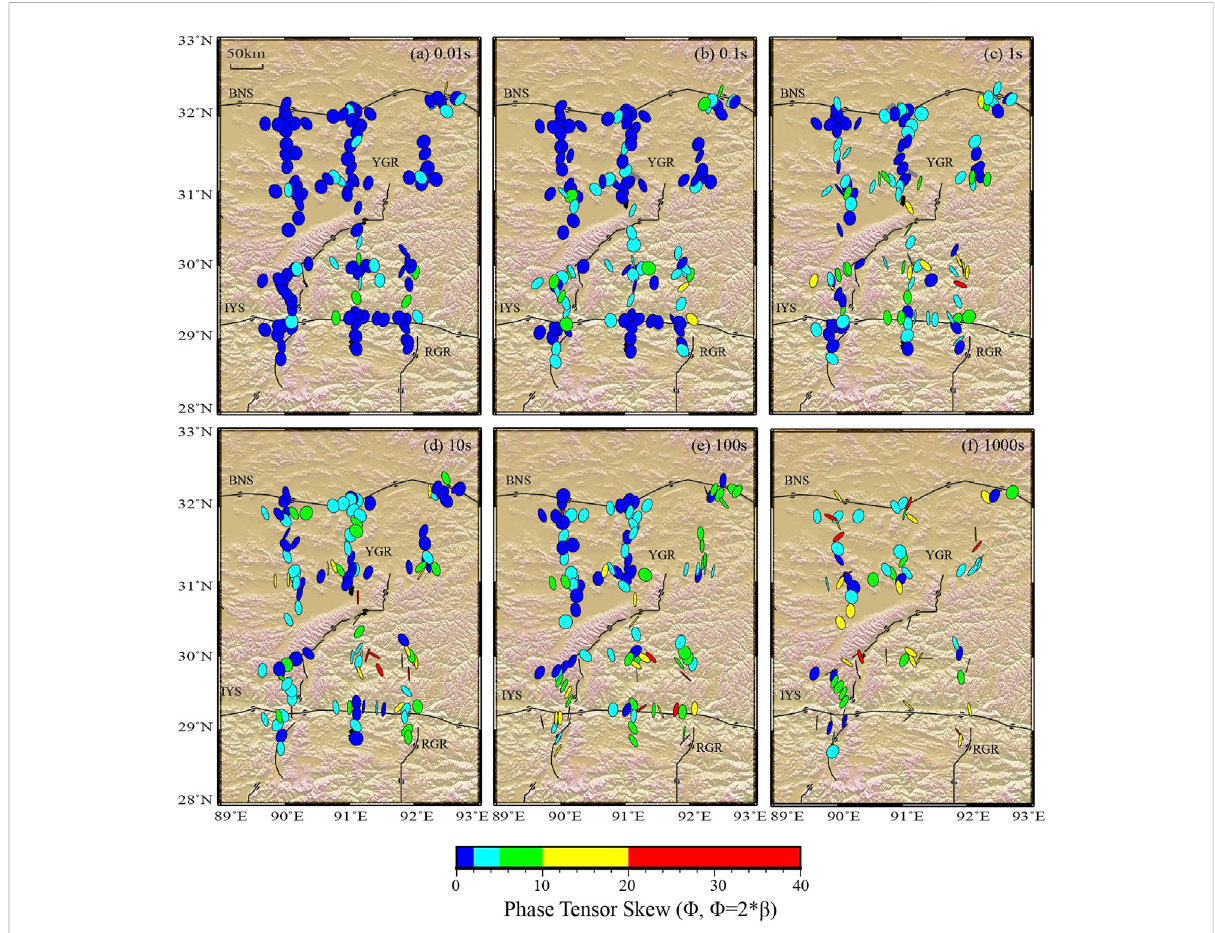
FIGURE 3 The phase tensor ellipses for periods. (A) 0.01 s, (B) 0.1 s, (C) 1 s, (D) 10 s, (E) 100 s, (F) 1,000 s. The colors of the ellipses indicate the skew angle β